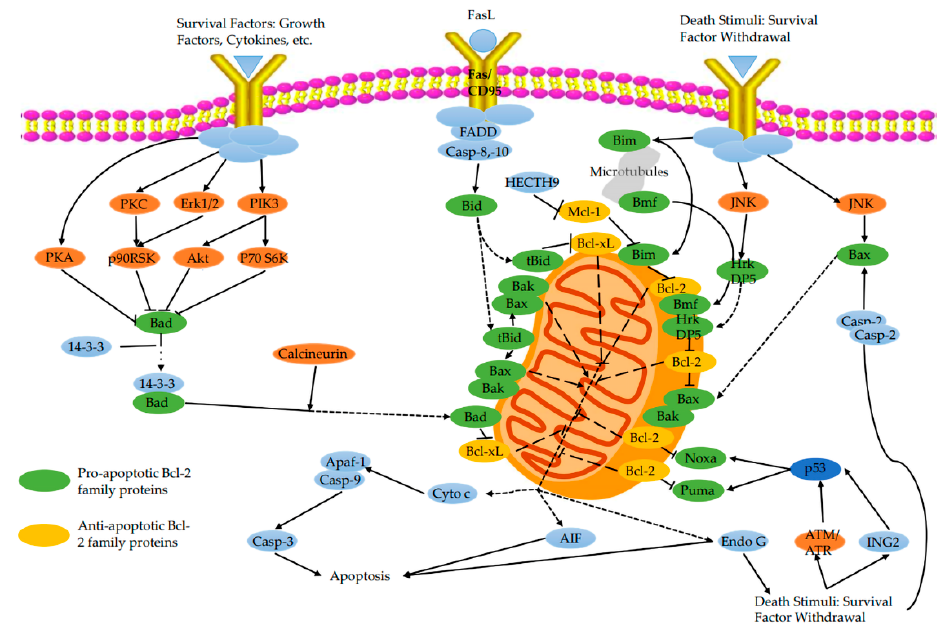
Figure 4. Signal transduction of pro-and anti-apoptotic Bcl-2 family proteins. Bcl-2 family proteins can accurately promote the mitochondrial permeability transition that allows the outflow of mitochondrial content. They can also induce the opening of mitochondrial MPTP and promote the release of apoptosis-related proteins. The Bcl-2/Bax ratio of the Bcl-2 family determines cell survival or apoptosis after certain stimuli.